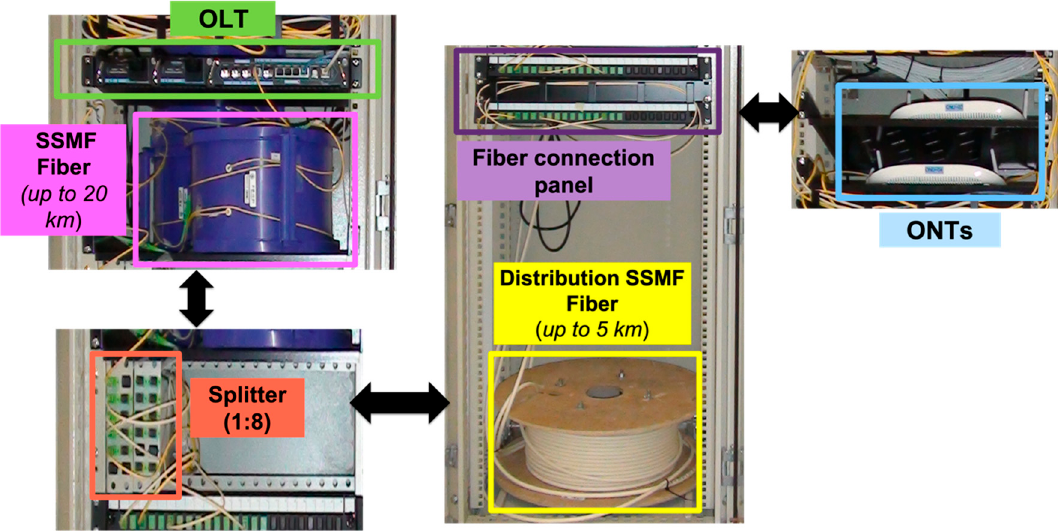
Figure 5. Real structure of the GPON testbed and its devices.